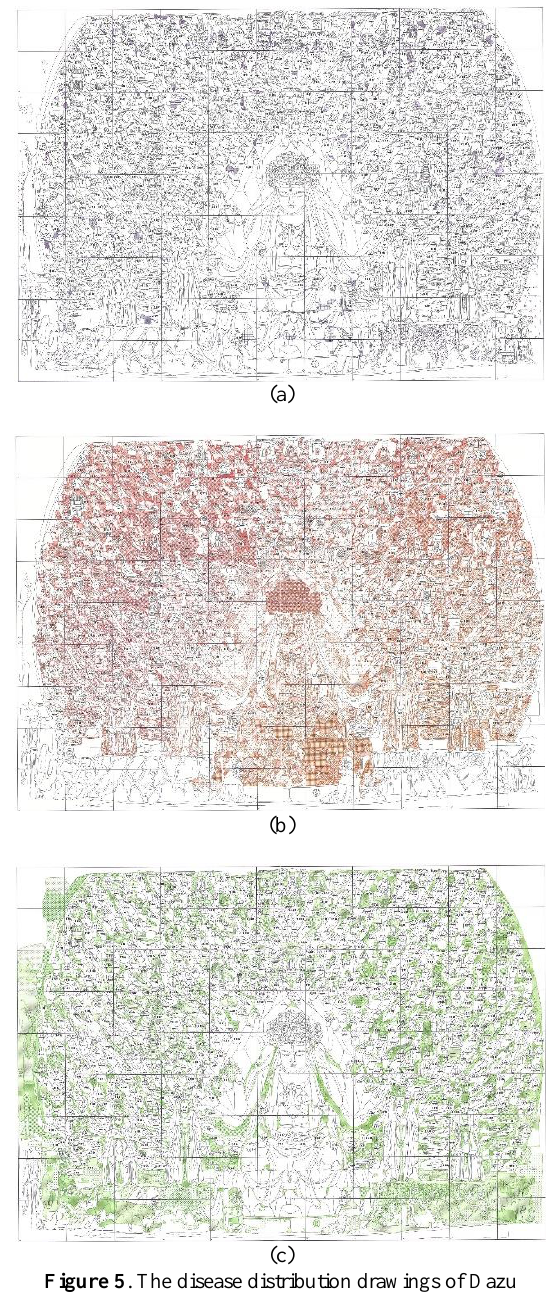
Figure 5 . The disease distribution drawings of Dazu thousand-hand